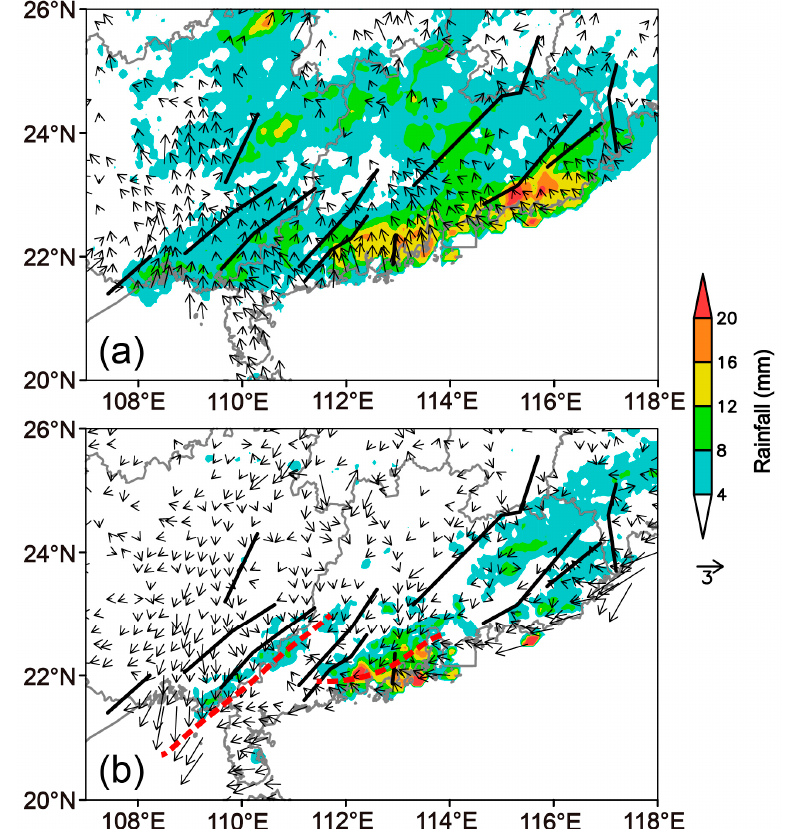
Figure 8. Composite distributions of rainfall (color-shaded; units: mm) and surface wind vectors (units: m s − 1 ) for the OWSRs in the ( a ) SWLLJ and ( b ) ACR situations. The lines indicate the mountains, and the dashed line in ( b ) indicates the convergence line between southeasterly winds and northerly